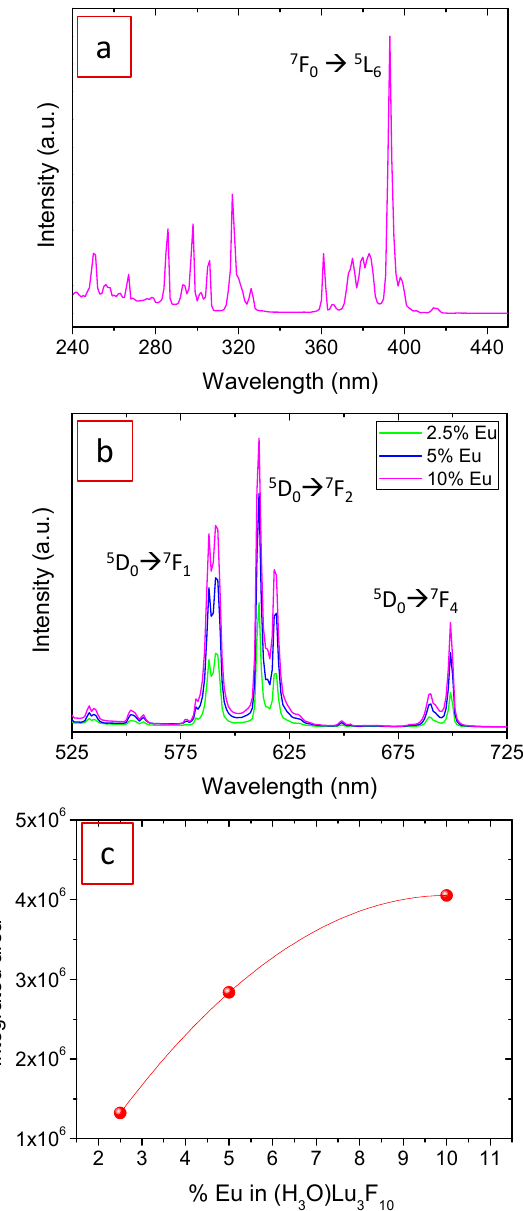
Figure 6. ( a ) Excitation spectrum of 10% Eu 3+ -doped (H 3 O)Lu 3 F 10 nanoparticles recorded at an emission wavelength of 611 nm; ( b ) emission spectra of (H 3 O)Lu 3 F 10 nanoparticles doped with 2.5%, 5%, and 10% Eu 3+ recorded under an excitation wavelength of 394 nm; ( c ) integrated area, from 525 to 725 nm, of the spectra shown in (b) versus Eu content.